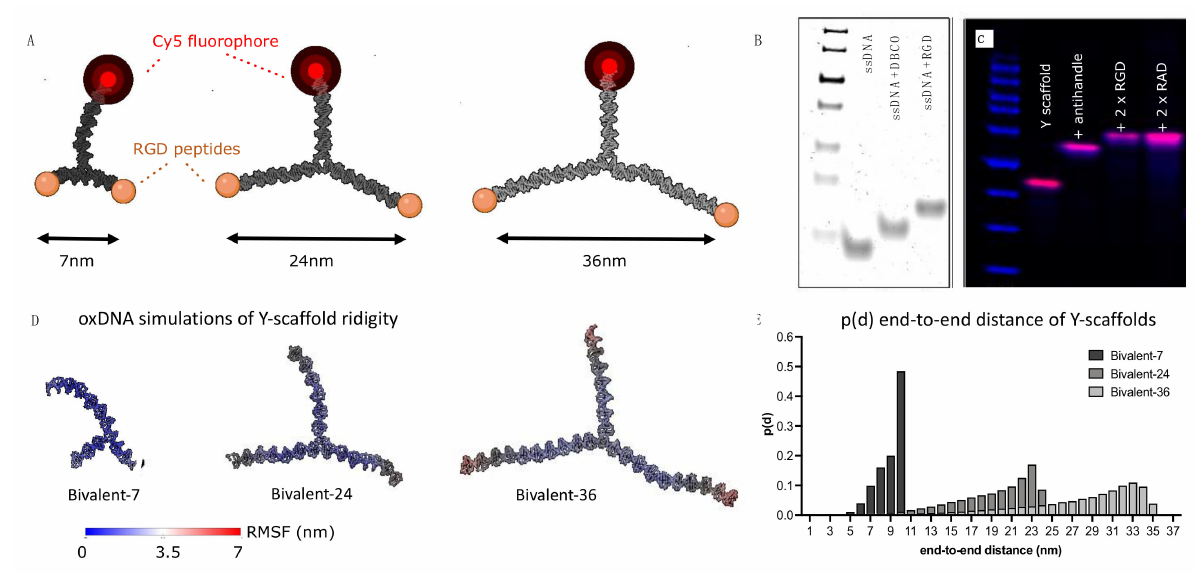
Figure 4. Bivalent DNA scaffold library with increasing ligand spacing. ( A ) Snapshots from sim- ulated Y-scaffolds, with schematically added labels (red) for detection and RGD ligands (orange) for integrin binding. ( B ) PAGE gel analysis of DNA-peptide conjugation. ( C ) Agarose gel analysis of Y scaffold assembly; Lane 1: Y-scaffold; Lane 2: Y-scaffold + ssDNA anti-handles; Lane 3+4: Peptide-functionalized Y-scaffold (blue = DNA ladder, pink = Cy5 label). ( D ) OxDNA simulation of the Y-scaffold library, with representation of the root mean square fluctuation (RMSF). ( E ) Inter-ligand spacing probability distribution p(d) based on oxDNA